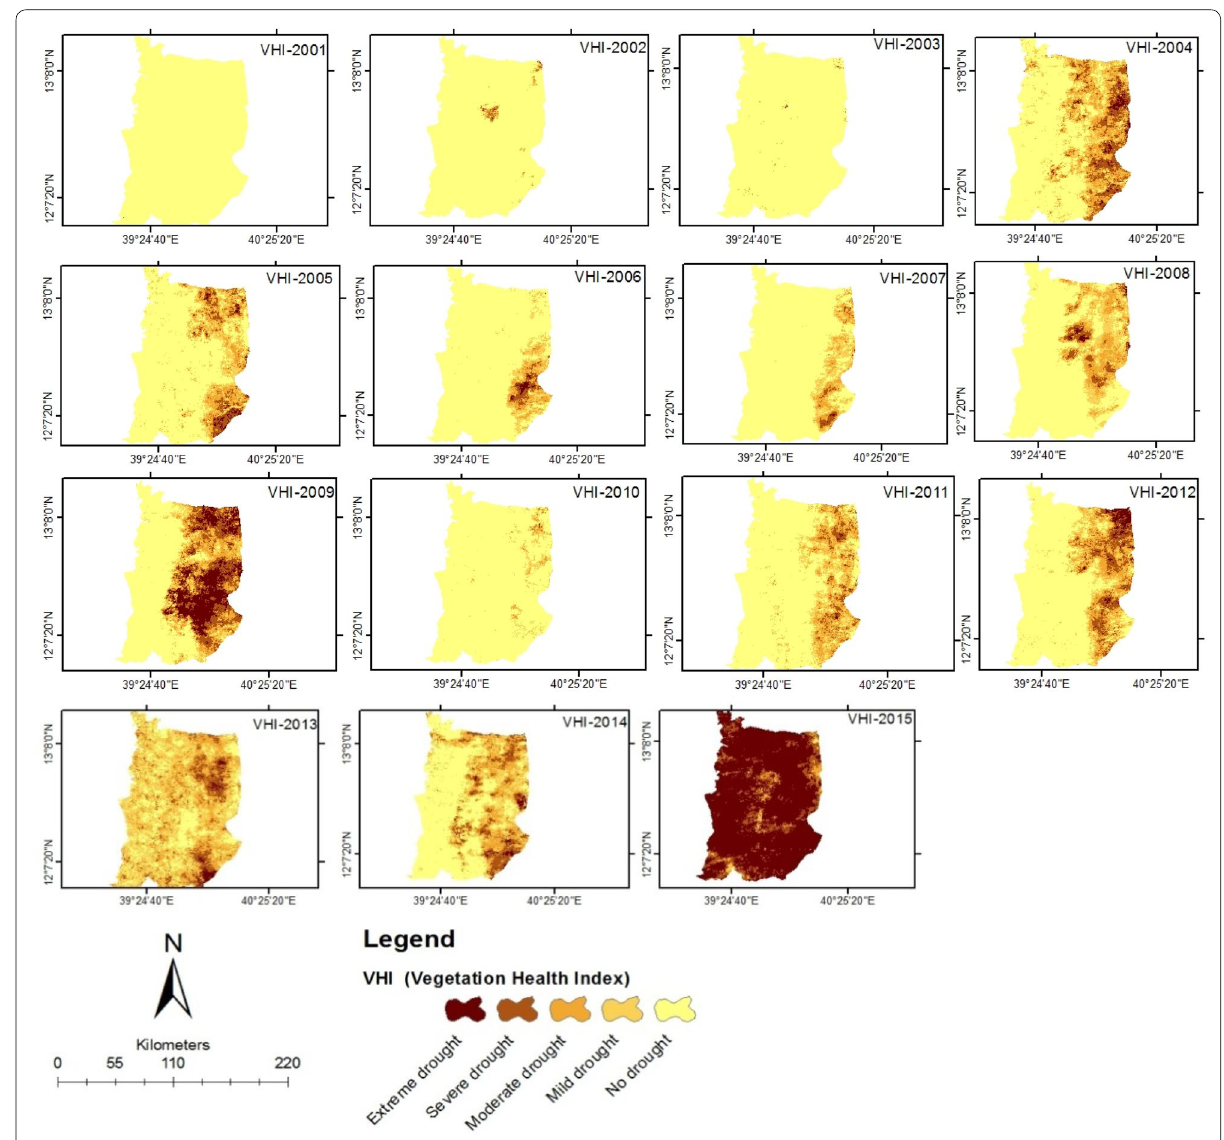
Fig. 7 A Spatio-temporal agricultural drought severity by VHI in all districts of the study